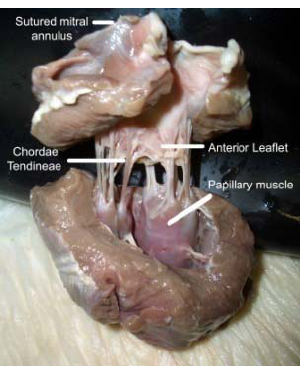
Figure 2: The mitral valve with a small segment of left ventricular muscle left connecting the papillary